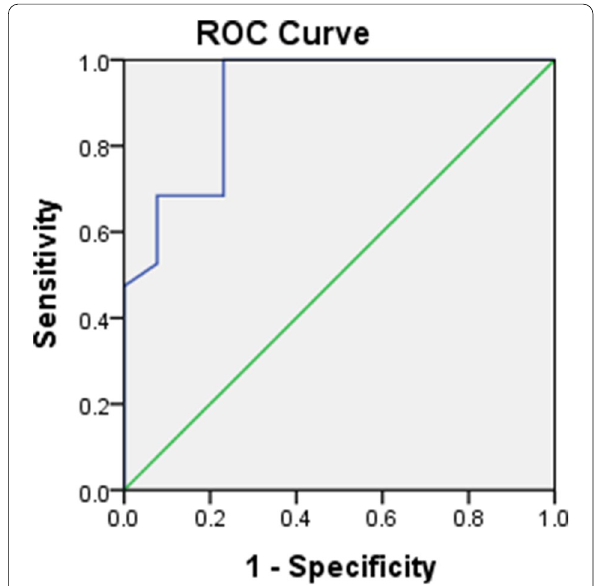
Fig. 2 ROC curve for prediction of metabolic syndrome in postmenopausal women. ROC curve for prediction of metabolic syndrome in postmenopausal women using cutoff value of ng/ml for hepcidin. The AUC, sensitivity, and specificity were 0.907, 100%, 71.4% respectively with p values < 0.001